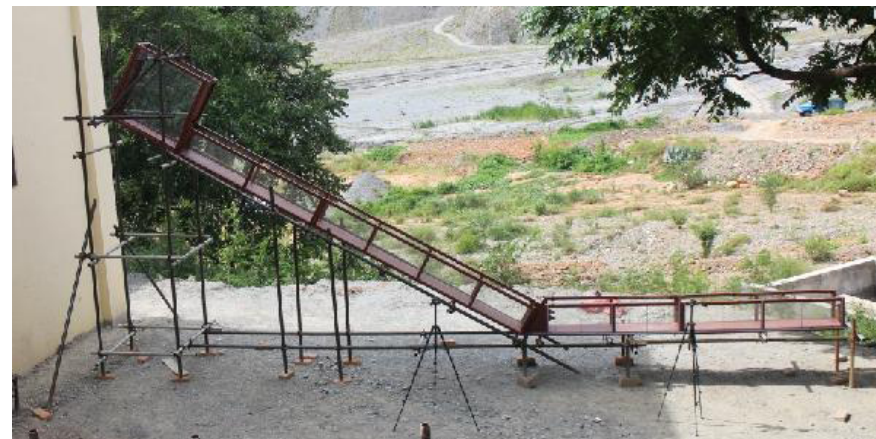
Figure 14. Large-scale flume for the field test.